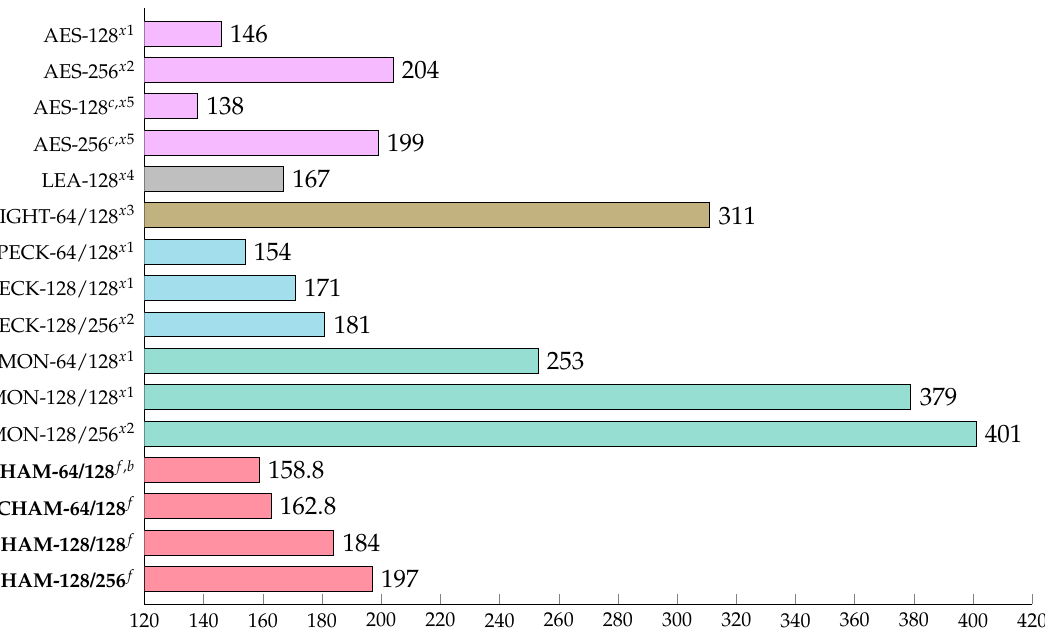
Figure 8. Comparison of execution time for CHAM with other block ciphers on 8-Bit AVR microcontrollers in terms of clock cycles per byte, c : Counter mode of operation, b : 16-bit counter for CHAM-64/128, f : Fixed-key scenario, x 1: [17], x 2: [18], x 3: [8], x 4: [5], x 5: